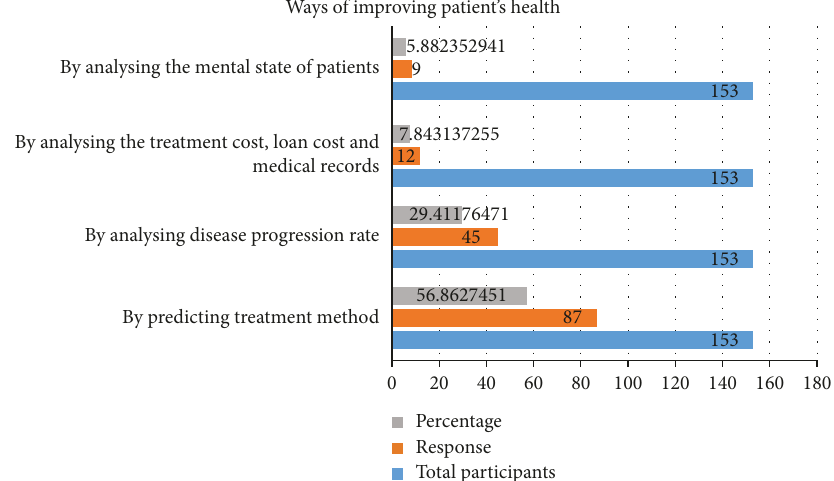
Figure 5: Graphical representation of patient’s health improvement through AI.